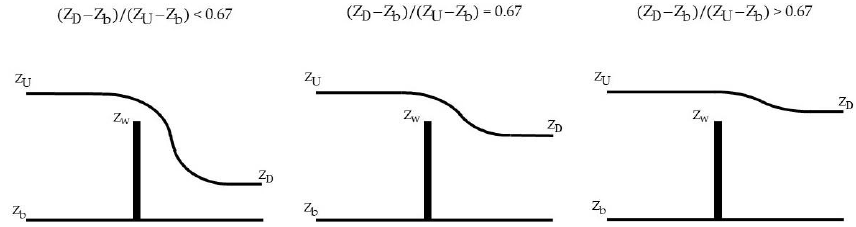
Figure 3. Schematic definition of the scope of application of Equations (4) and (5).